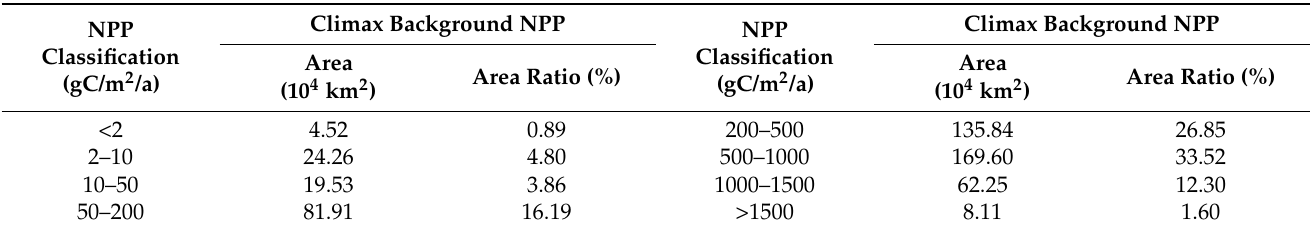
Figure 9. Spatial distribution of climax background NPP in China’s forest, grassland and desert ecosystems. Table 7. Classification statistics of the climax background NPP in China’s forest, grassland and desert ecosystems.